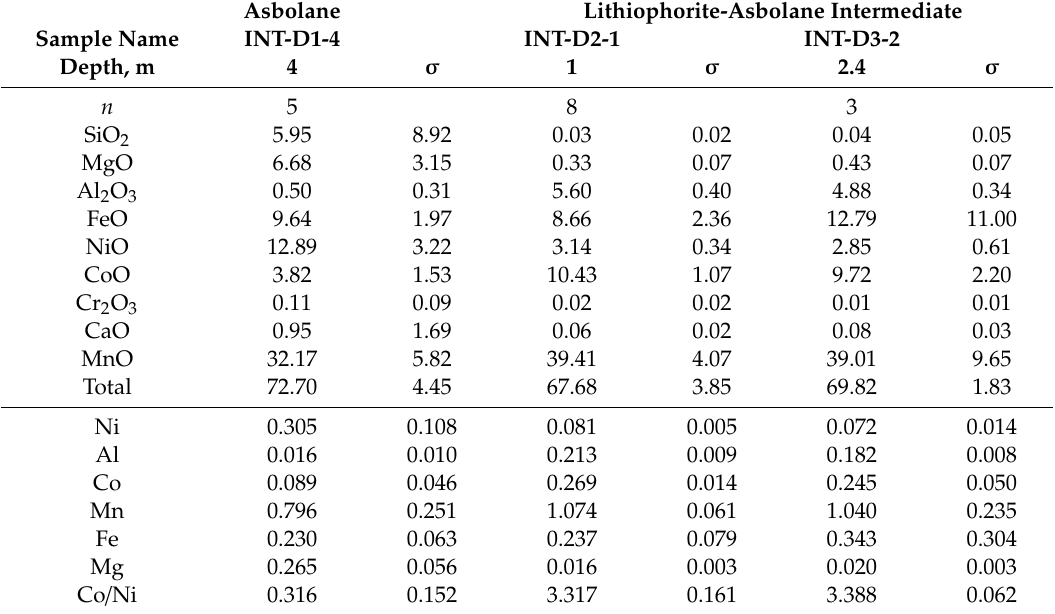
Figure 14. Co-Ni-Al ternary diagram (wt%) displaying the mineralogy and composition of asbolane and lithiophorite-asbolane intermediate in the limonite horizon of the Intex deposit. Table 6. Average chemical compositions (wt%) and structural formula (apfu) of the representative. asbolane and lithiophorite-asbolane intermediate in the limonite horizon.